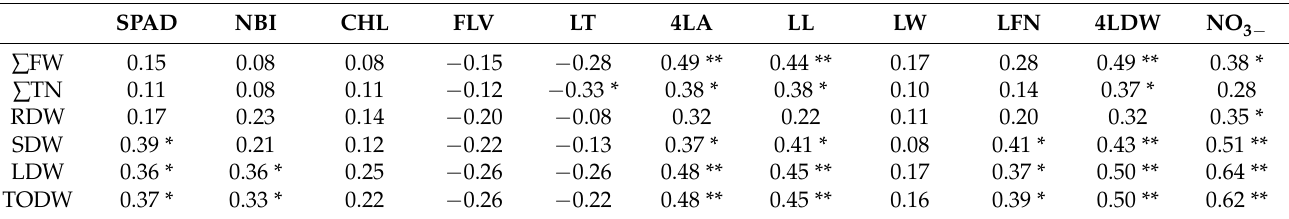
Table 5. Pearson’s correlation coefficients between 4th leaf indexes at 21 DAT and potato plant parameters were evaluated at different harvests in response to Otaz ú ’s nutrient solution to generate a prognosis for the yield of nuclear seed potatoes.